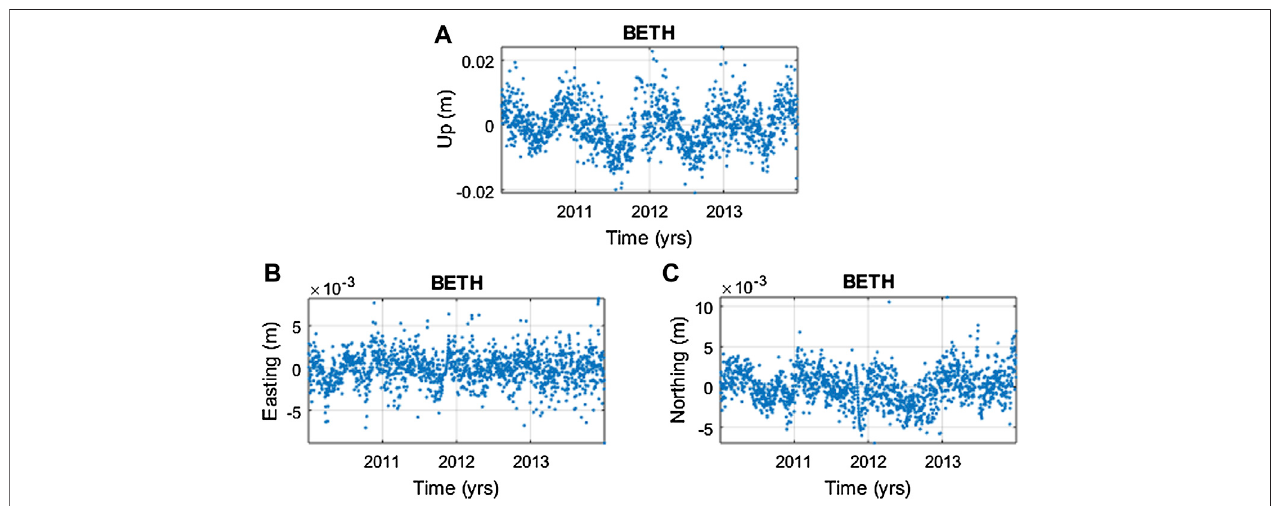
FIGURE 1 | cGPS daily position time series of station BETH located in Bethlehem, South Africa. (A) Detrended and interpolated vertical surface displacement time series at the station. (B,C) are detrended and interpolated horizontal surface displacement time series x (easting) and y (northing) directions, respectively. 27.